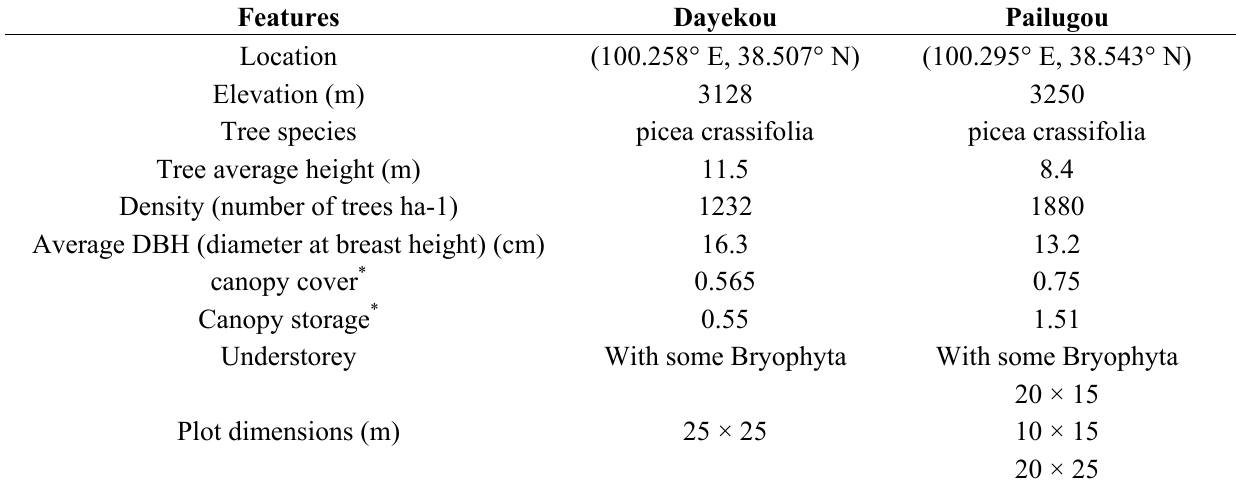
Table 1. Main features of the Dayekou and Pailugou experimental sites in the upper reaches of the Heihe River Basin in